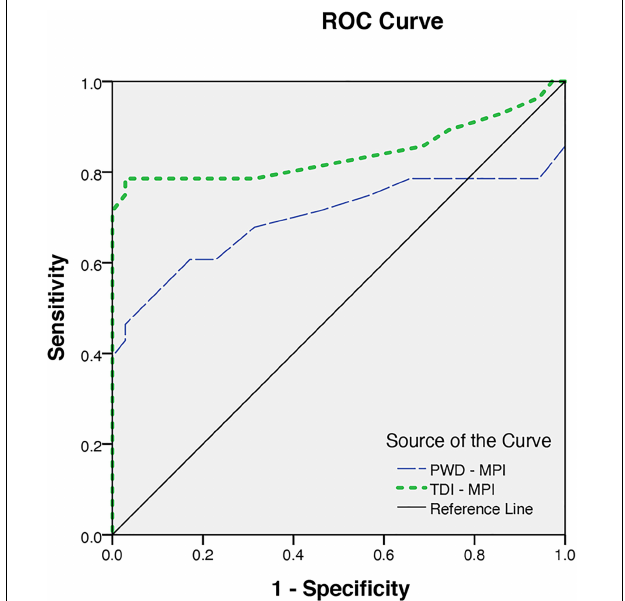
FIGURE 3 | The receiver operating characteristics for myocardial performance index (MPI) obtained from pulsed Doppler (PWD-MPI) and tissue Doppler-derived MPI